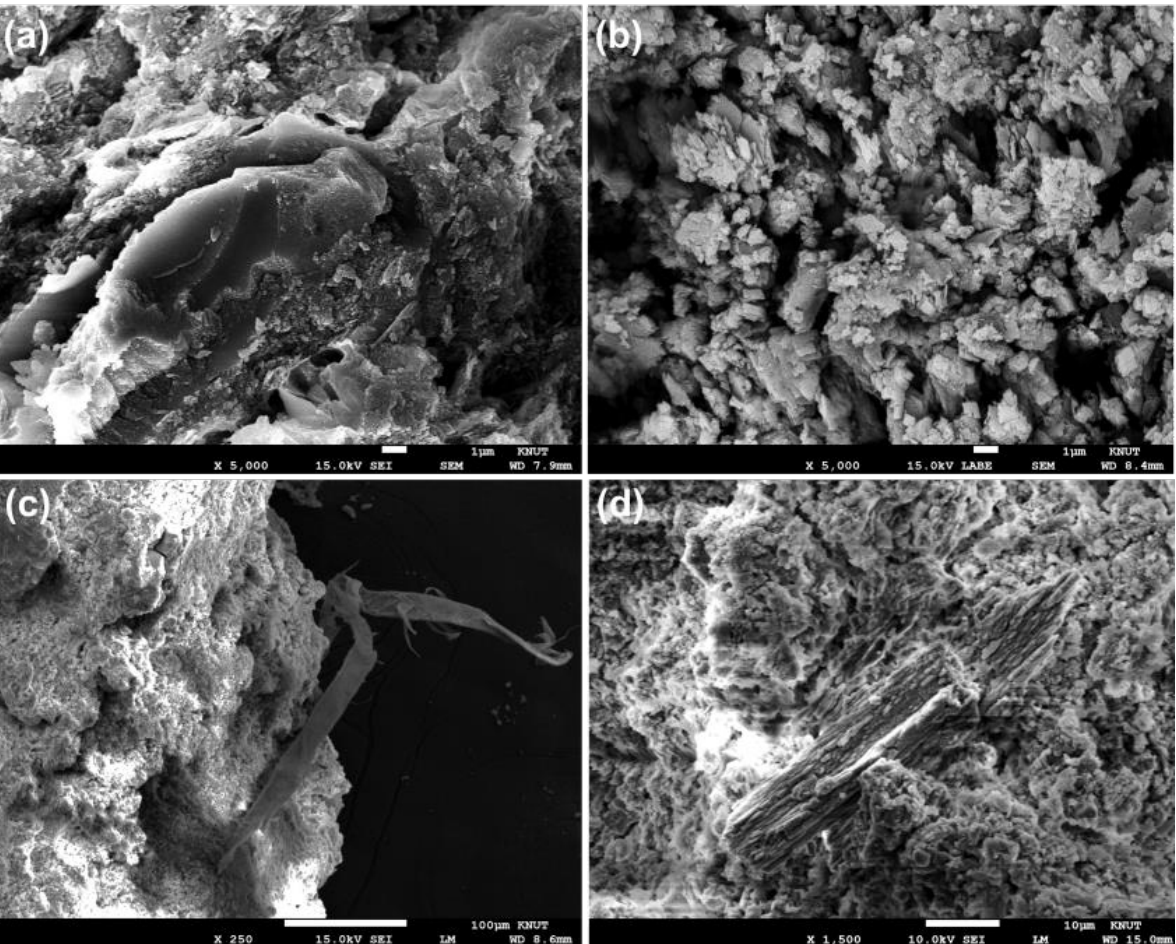
Figure 10. Scanning electron microscope (SEM) image of a part of mural sample. ( a ) Earthen layer. ( b ) Lime layer. ( c ) Fiber in lime layer. ( d ) shell in lime layer.